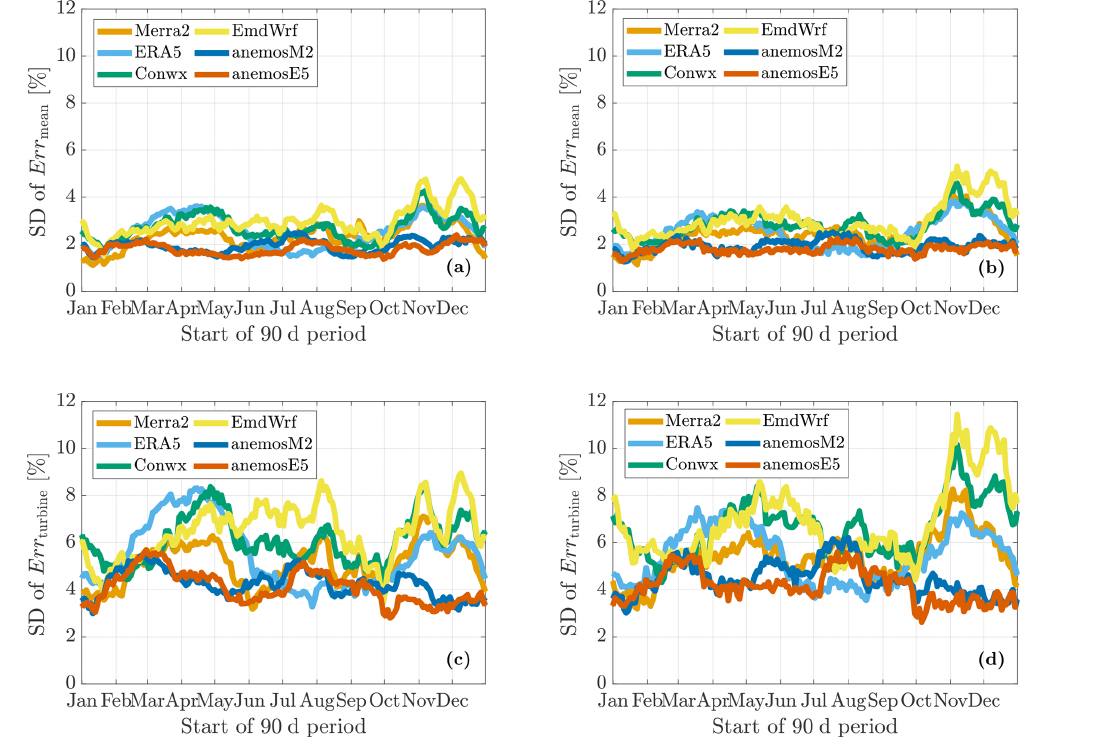
Figure 11. Bias variations between the sites (1SD – standard deviation) with regard to the accuracy of predicting the mean wind speed (a, b) and the theoretical energy production of a wind turbine (c, d) . The panels on the left (a, c) refer to the VR method, while in panels (b) and (d) the results produced by the LR method are